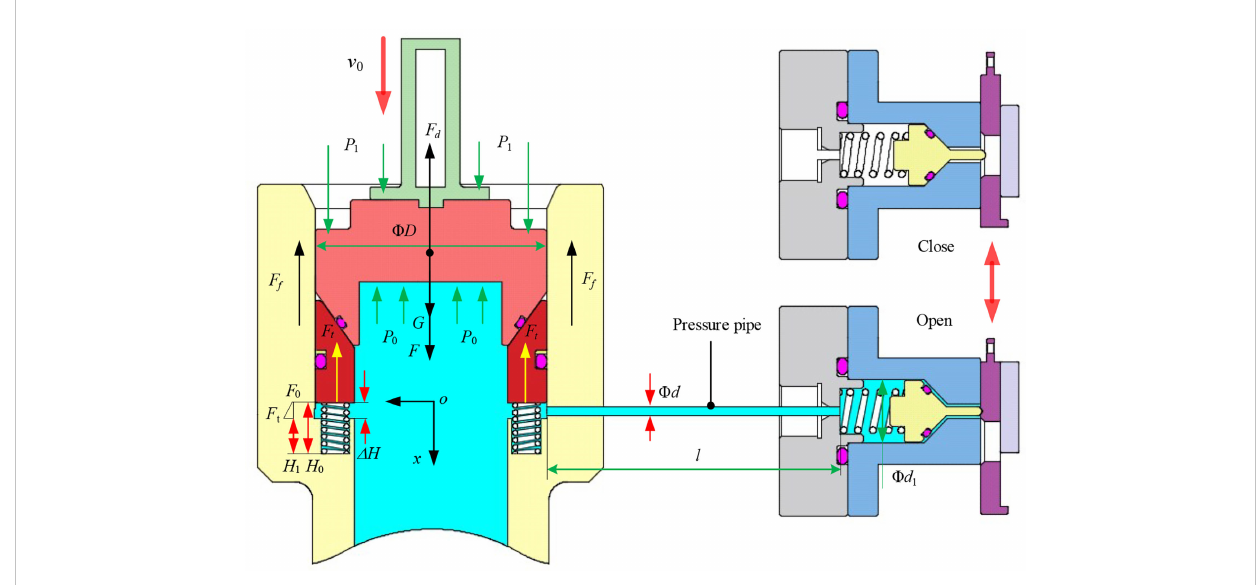
FIGURE 6 Stress analysis diagram of dynamic seal